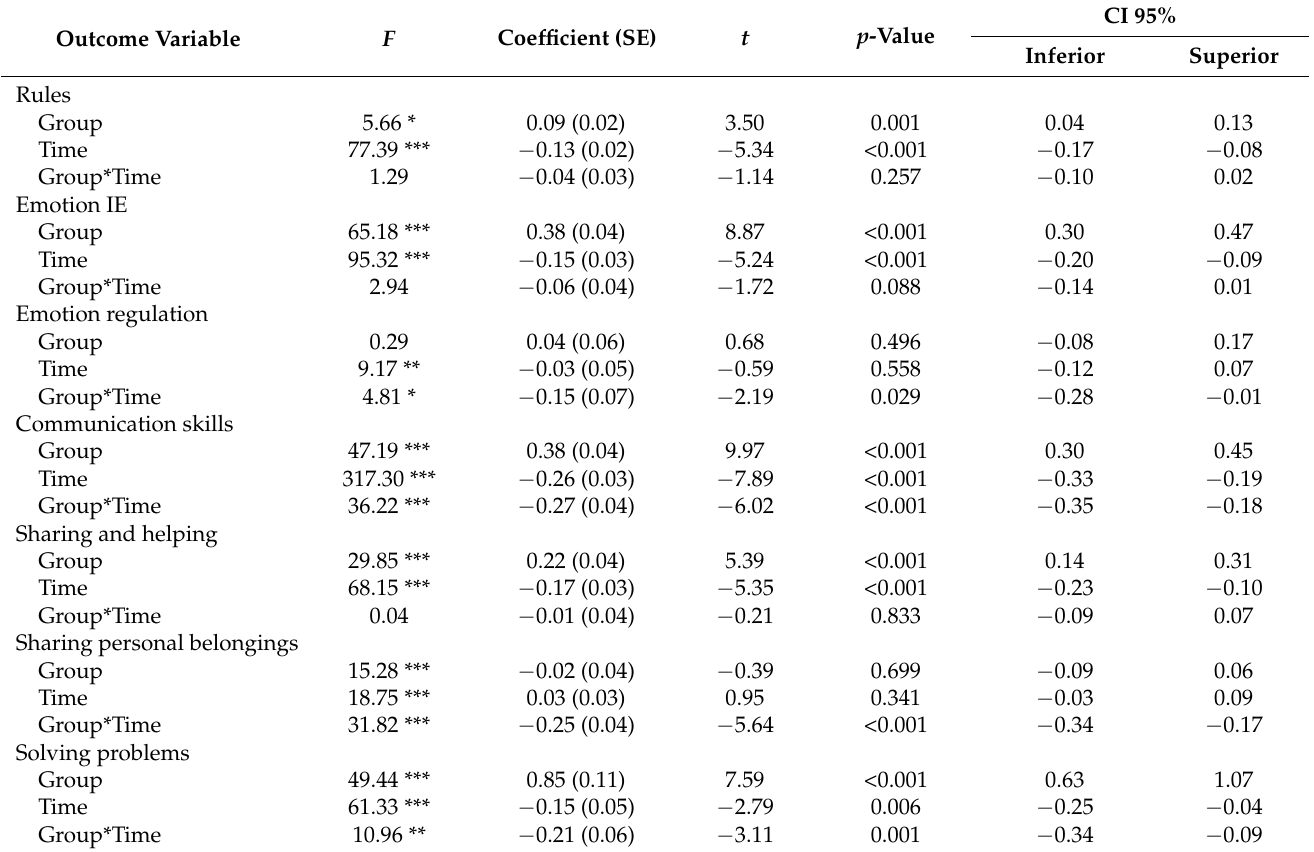
Table 3. Results of generalized linear mixed models estimating change in the program’s outcomes.